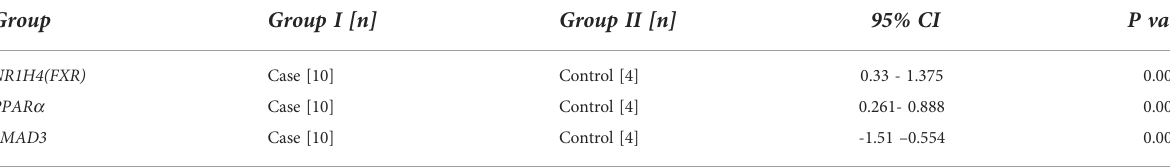
TABLE 6 Semi-quantitative WB results (T test). Group